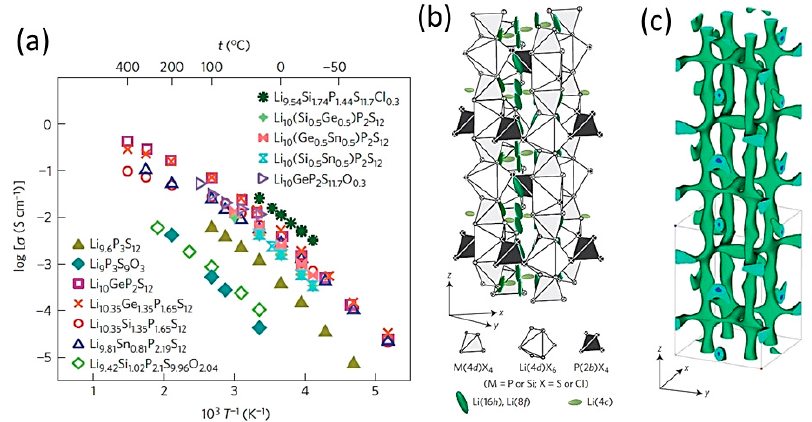
Figure 20. ( a ) Arrhenius conductivity plots of Li 11 − x M 2 − x P 1 + x S 12 ( M = Ge, Sn, Si) structures, Li 9.6 P 3 S 12 , and Li 9.54 Si 1.74 P 1.44 S 11.7 Cl 0.3 electrolytes. ( b ) Crystal structure of Li 9.54 Si 1.74 P 1.44 S 11.7 Cl 0.3 . The thermal ellipsoids were drawn with 50% probability. The framework structure consists of one-dimensional polyhedral chains (edge-sharing M(4 d ) X 4 and Li(4 d ) X 6 ) connected by P(2 b ) X 4 tetrahedra. Conducting